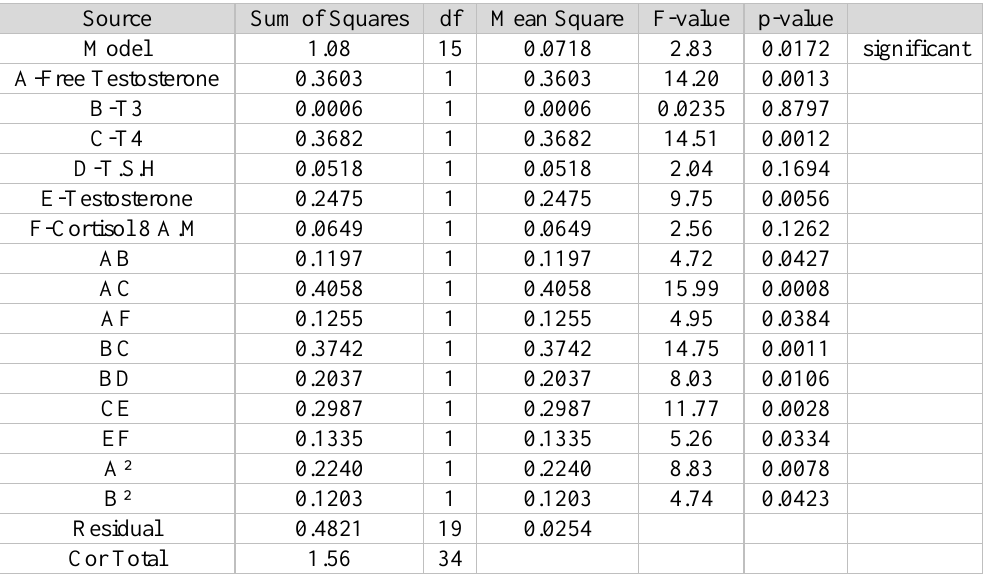
Table6. ANOVA for Reduced Quadratic